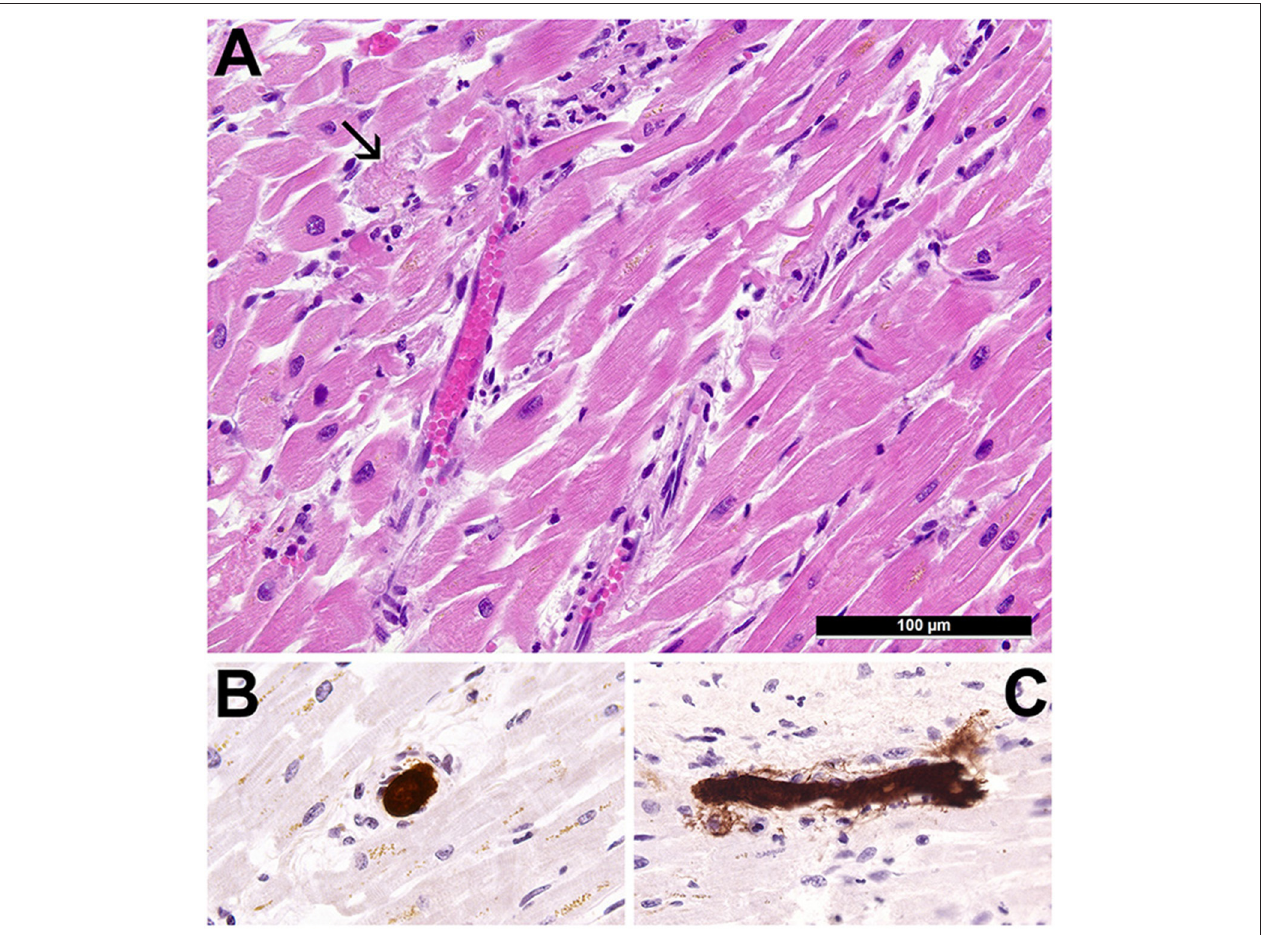
FIGURE 1 | Cardiopathological findings. (A) Morphology of the heart showing multifocal inflammatory infiltrates consisting of neutrophilic granulocytes, lymphocytes and histiocytes, capillarostasis, and perifocal single-cell necroses of cardiomyocytes (arrow) (H&E, × 400). (B,C) Immunohistochemical staining for fibrin demonstrating cross section and longitudinal section of capillaries with prominent microthrombi occluding the lumens (immunohistochemistry for fibrin, ×